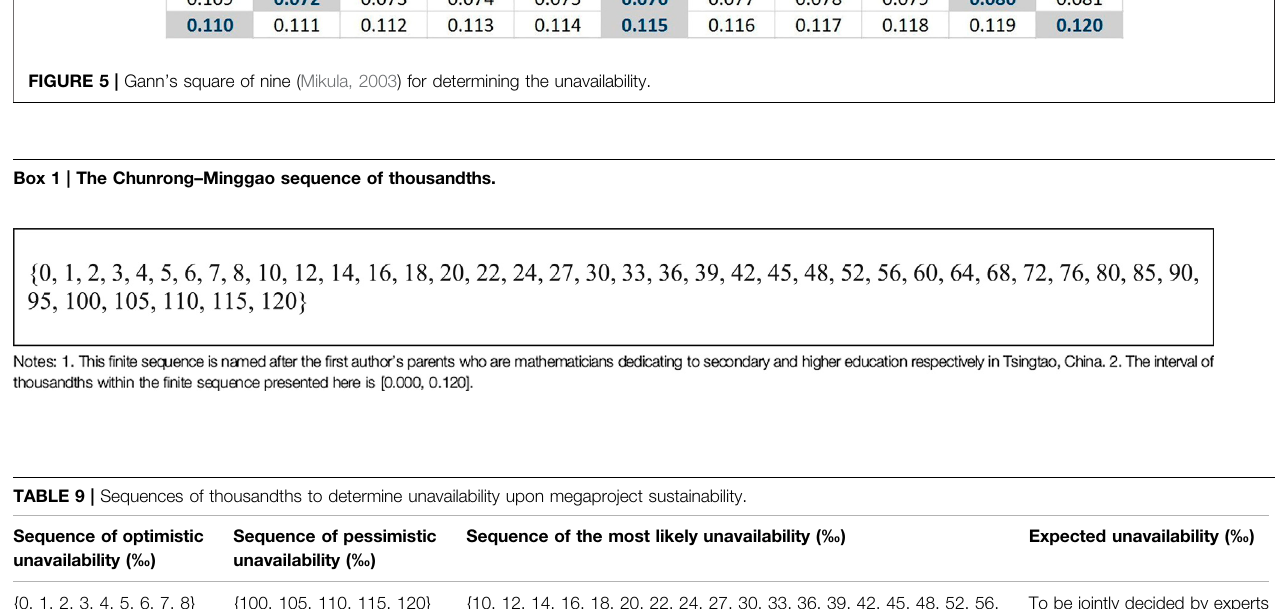
To be jointly decided by